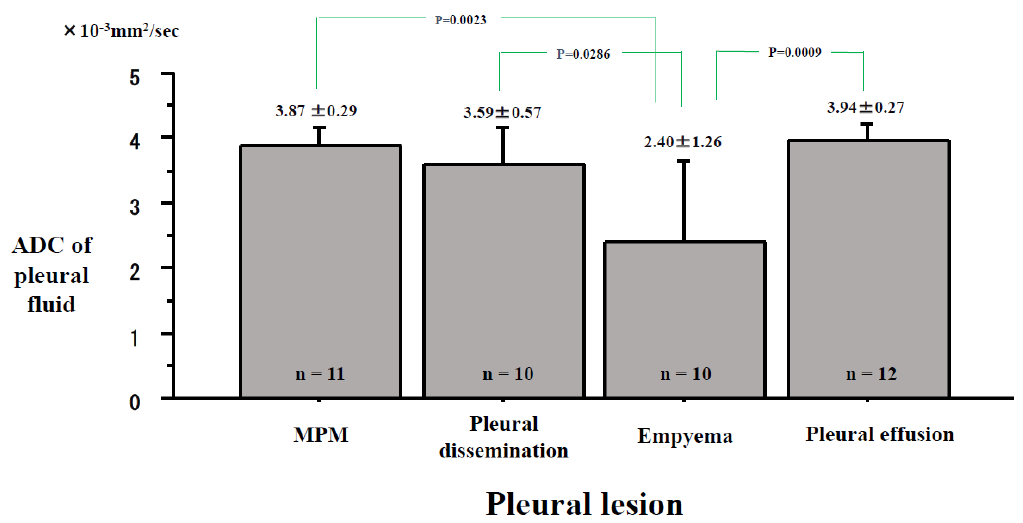
Figure 6. Di ff erences in the apparent di ff usion coe ffi cient (ADC) of the pleural e ff usion inside the Figure 6. Differences in the apparent diffusion coefficient (ADC) of the pleural effusion inside the pleural lesions. The ADCs of pleural fluid were 3.87 ± 0.29 × 10 − 3 mm 2 / s in Malignant Pleural pleural lesions. The ADCs of pleural fluid were 3.87 ± 0.29 × 10 -3 mm 2 /s in Malignant Pleural Mesothelioma (MPM), 3.59 ± 0.57 × 10 − 3 mm 2 / s in the pleural dissemination, 2.40 ± 1.26 × 10 − 3 mm 2 / Mesothelioma (MPM), 3.59 ± 0.57 × 10 -3 mm 2 /s in the pleural dissemination, 2.40 ± 1.26 × 10 -3 mm 2 /s in the